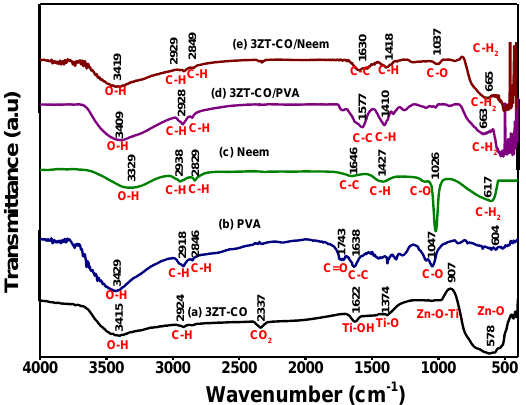
Figure 4. ( d ) 3ZT-CO / PVA, and ( e ) 3ZT-CO / Neem. Figure 4. The FTIR spectra of the prepared samples ( a ) 3ZT-CO, ( b ) PVA, ( c ) neem extract, ( d ) 3ZT-CO/PVA, and ( e ) 3ZT-CO/Neem.